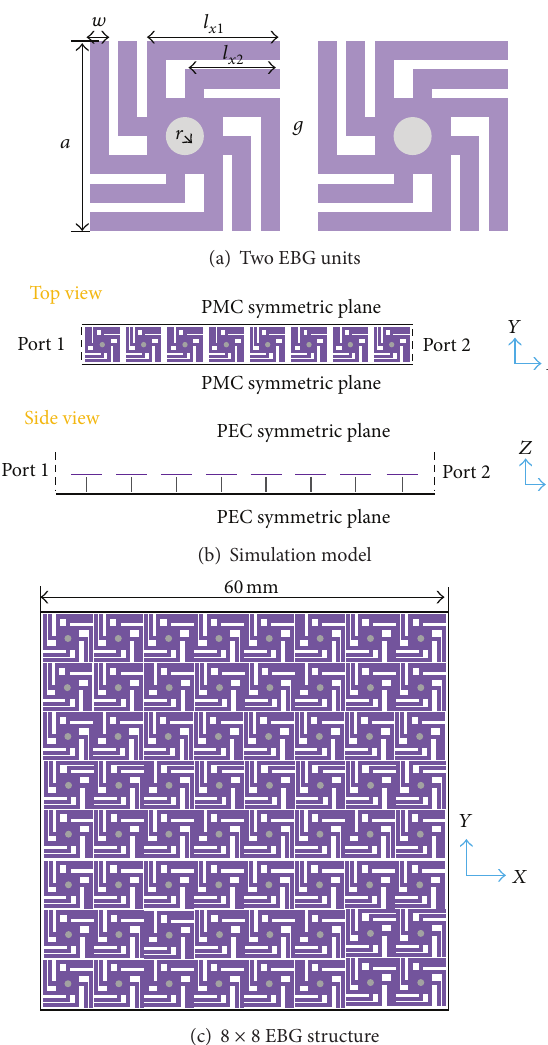
Figure 4: Geometry for the high impedance EBG